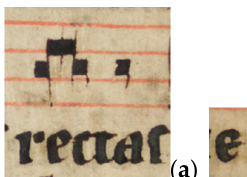
Figure 1. Details from National Archives, Reykjavik, Þjss “Antiphonarium 2”: ( a ) Double note. ( b ) Uncial form of the letter e .